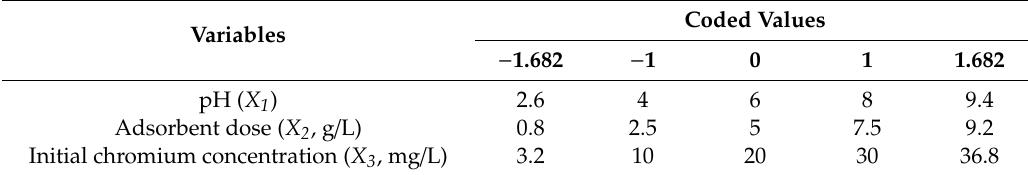
Table 1. Experimental variables and levels investigated by central composite design